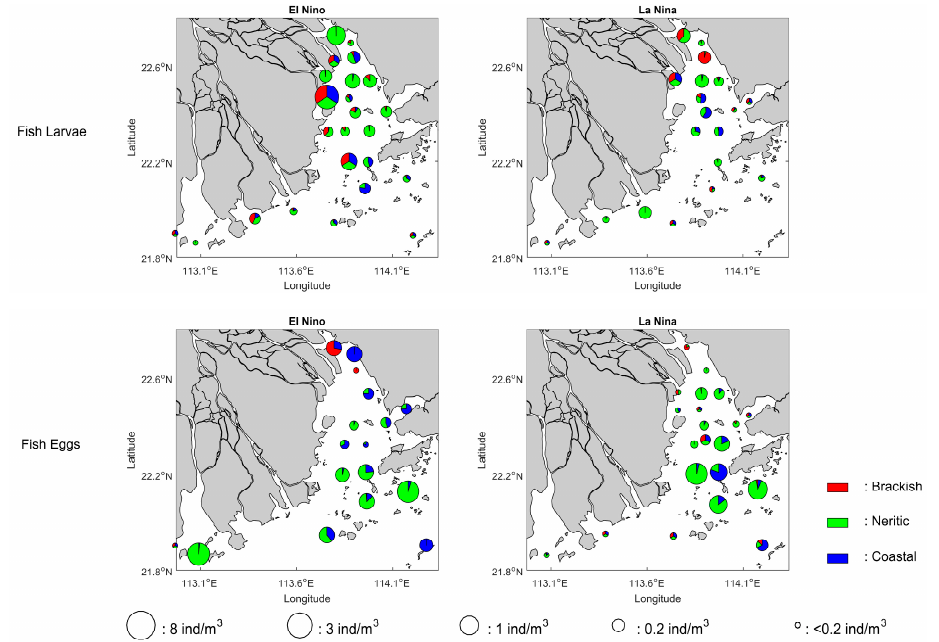
Figure 7. Abundance distribution and the associated partitions among the brackish, neritic, and coastal species of fish larvae and eggs associated with the El Niño and La Niña conditions.